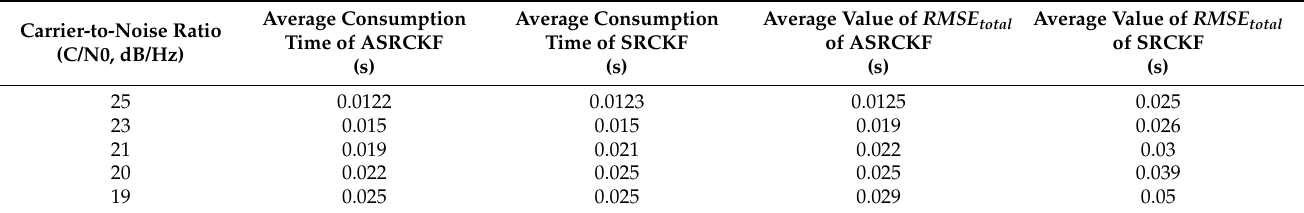
Table 2. The average time consumption and filtering performance of the two algorithms of ASRCKF and SRCKF when the C/N 0 is 25, 23, 21, 20, and 19 dB-Hz,